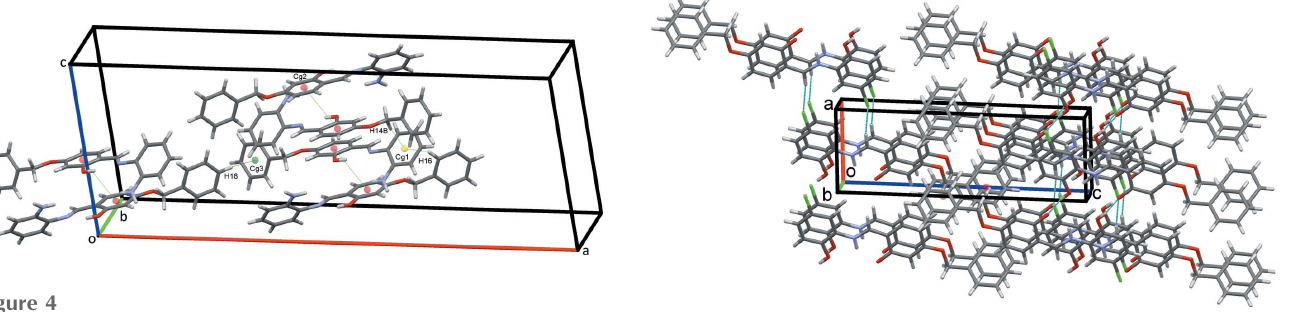
Figure 7 Overall packing for (II) viewed along the b- axis